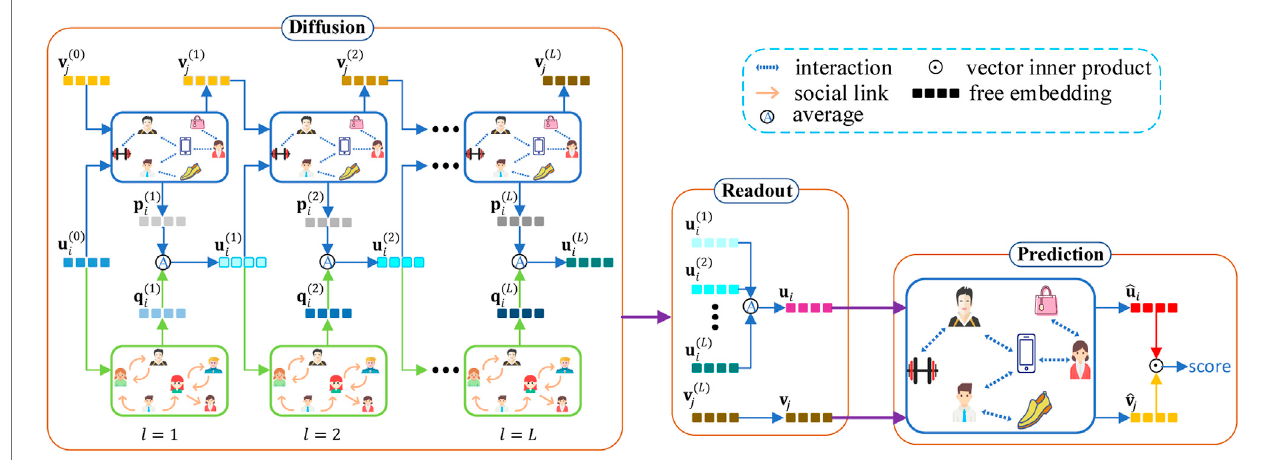
FIGURE 1 | The overall architecture of the proposed